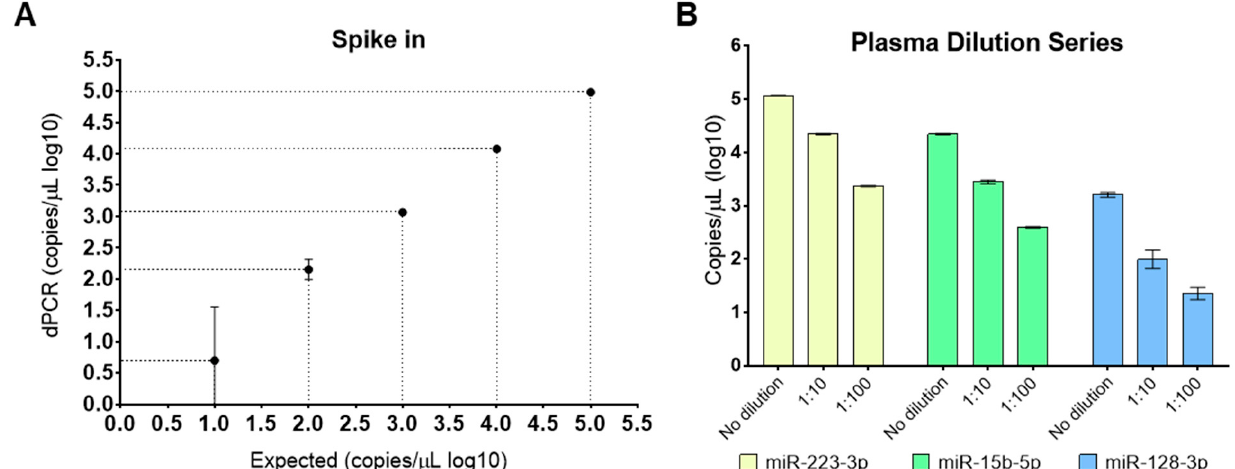
Figure 1. Digital PCR capability to detect miRNA in a wide range of concentrations. ( A ) Regression analysis between expected (x-axis) and dPCR-assessed (y-axis) expression of serial dilutions (10 5 to 10 1 copies/ µ L) of synthetic cel-miR-54-3p in triplicate. The data are expressed as Log10 (miRNA copies/ µ L of the sample), and the bars represent the 95% confidence interval. ( B ) Expression levels of undiluted, 1:10, and 1:100 dilutions of miR-223-3p, miR-15b-5p, and miR-128-3p in one healthy subject in triplicate. No RNA extraction was performed on the plasma sample. The data are expressed as Log10(miRNA copies/ µ L of the sample), and error bars represent the 95% confidence interval.